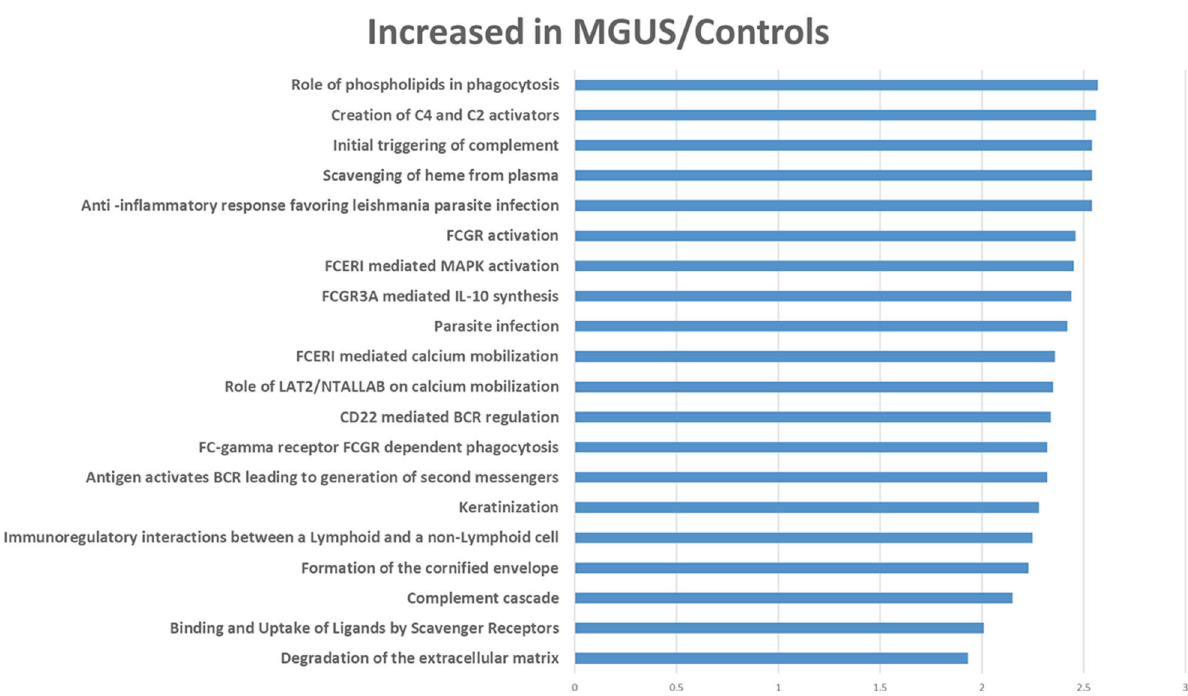
Fig. 3 Gene set enrichment analyses of proteins in MGUS and control samples compared to smoldering and active myeloma samples (only the top 20 pathways are reported). The values on the X axis are normalized enrichment scores and all were signi fi cant at an FDR corrected p value of <0.05.